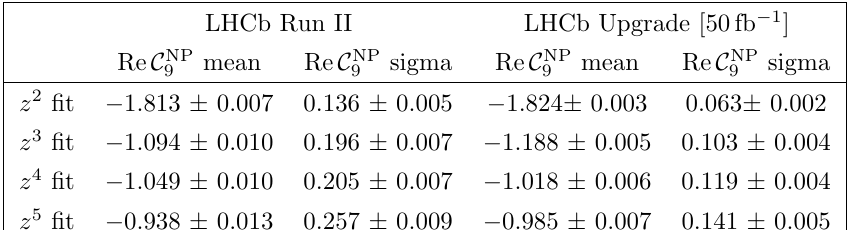
Table 4 . Expected central value and uncertainties for the C NP z 4 and z 5 (cid:12)ts for the BMP scenario when produced with non-zero z 4 coe(cid:14)cients as described in the text.